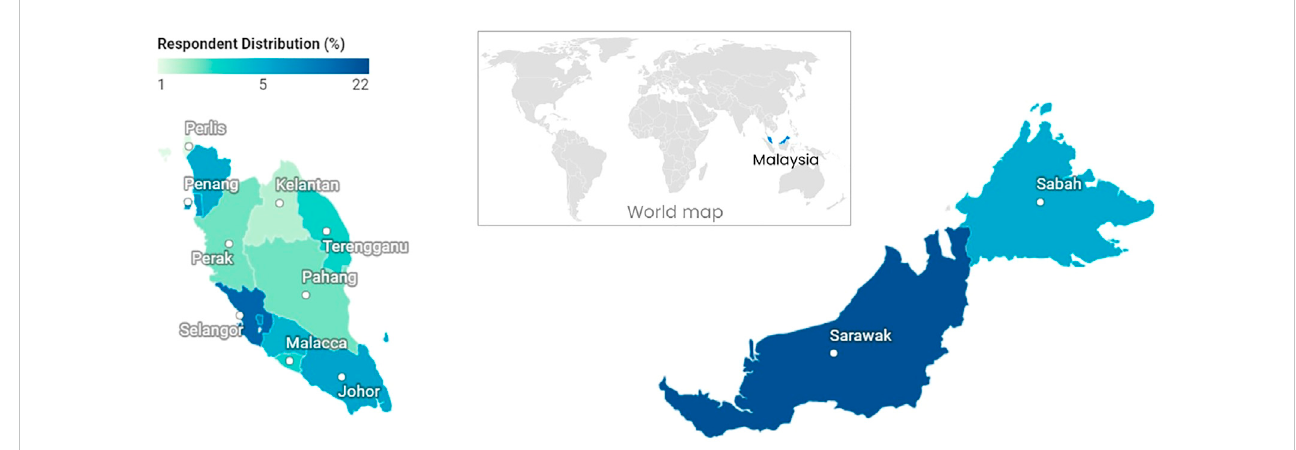
FIGURE 1 Distribution of respondents based on athletes ’ residence in Malaysia.